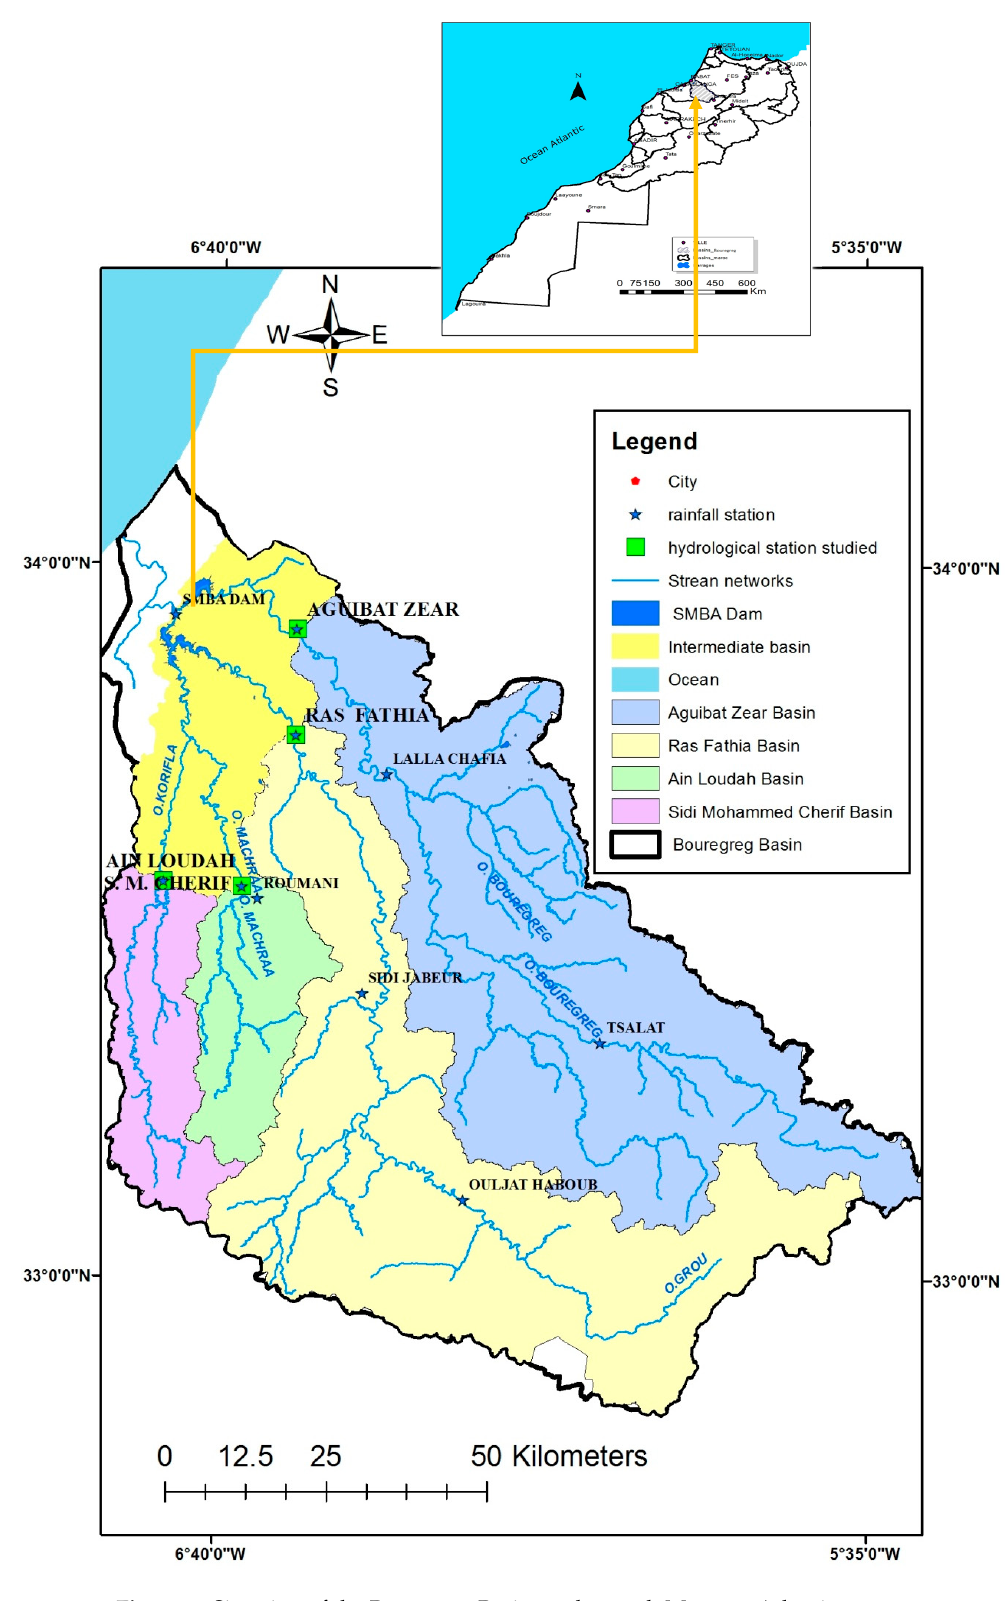
Figure 1. Situation of the Bouregreg Basin on the north Morocco Atlantic